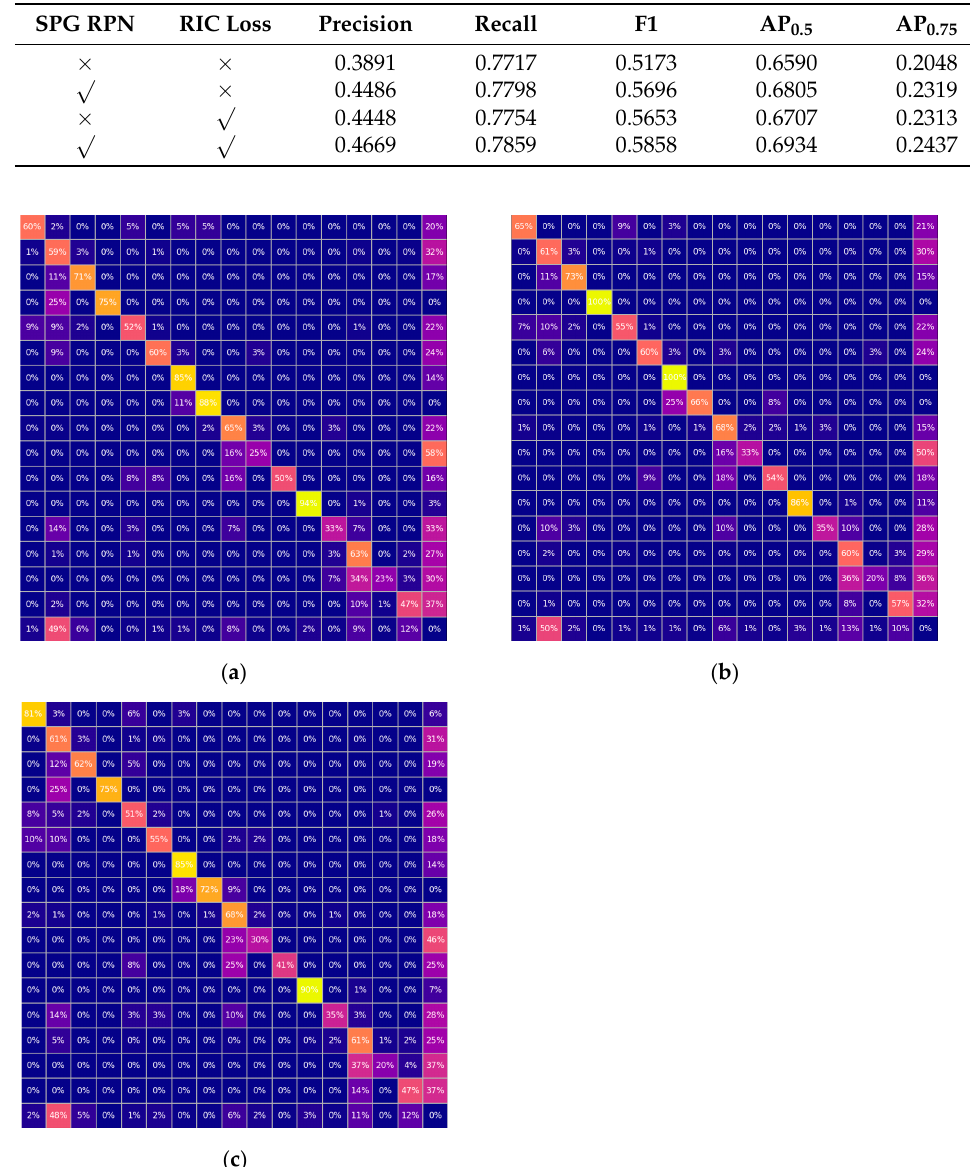
Figure 8. Visualization of the results by confusion matrixes. The horizontal axis corresponds to the predicted label and the vertical axis corresponds to the ground-truth label, respectively. Rows or columns 1 to 16 correspond to ore-oil, Container, Fishing, LawEnforce, Dredger, Cell-Container, Type1-10, and background, respectively. ( a ) The confusion matrix of the baseline. ( b ) The confusion matrix of the baseline with the SPG RPN. ( c ) The confusion matrix of the baseline with the RIC Loss.